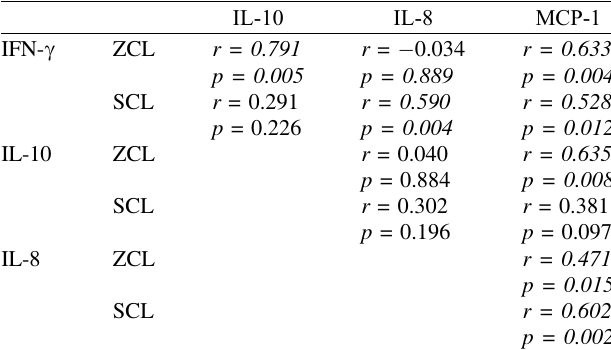
Table 2. Correlation between mRNA expression levels of studied cytokines and chemokines within ZCL and SCL